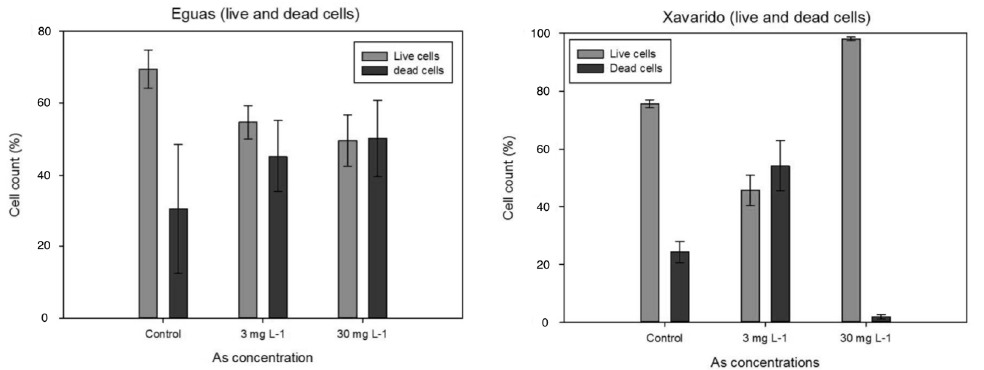
Figure 3. Live/Dead count for Eguas and Xavarido (mean ± SD, n = 3) exposed to different added As concentrations.